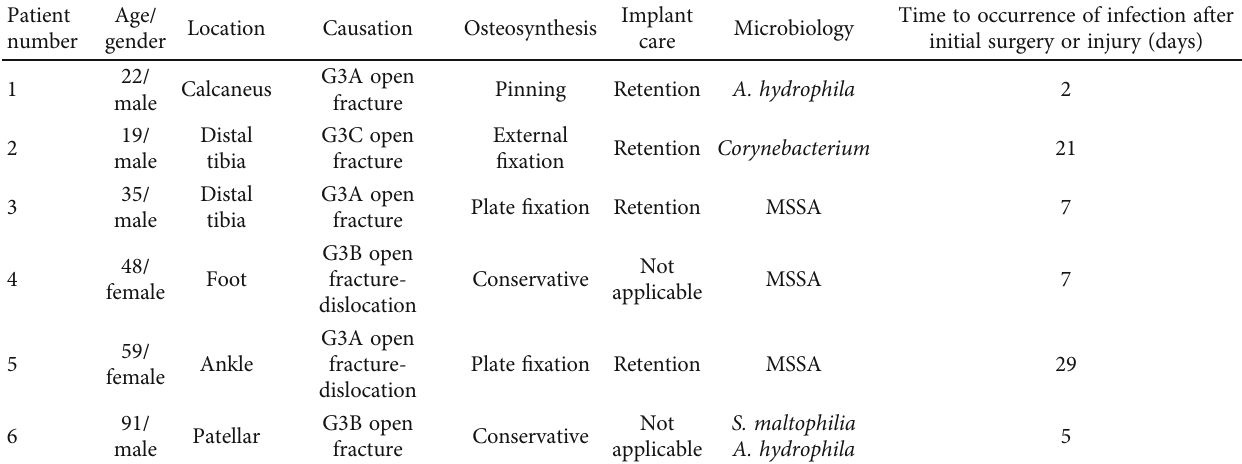
Table 1: Characteristics of current series of patients with musculoskeletal infection, treated with CLAP.